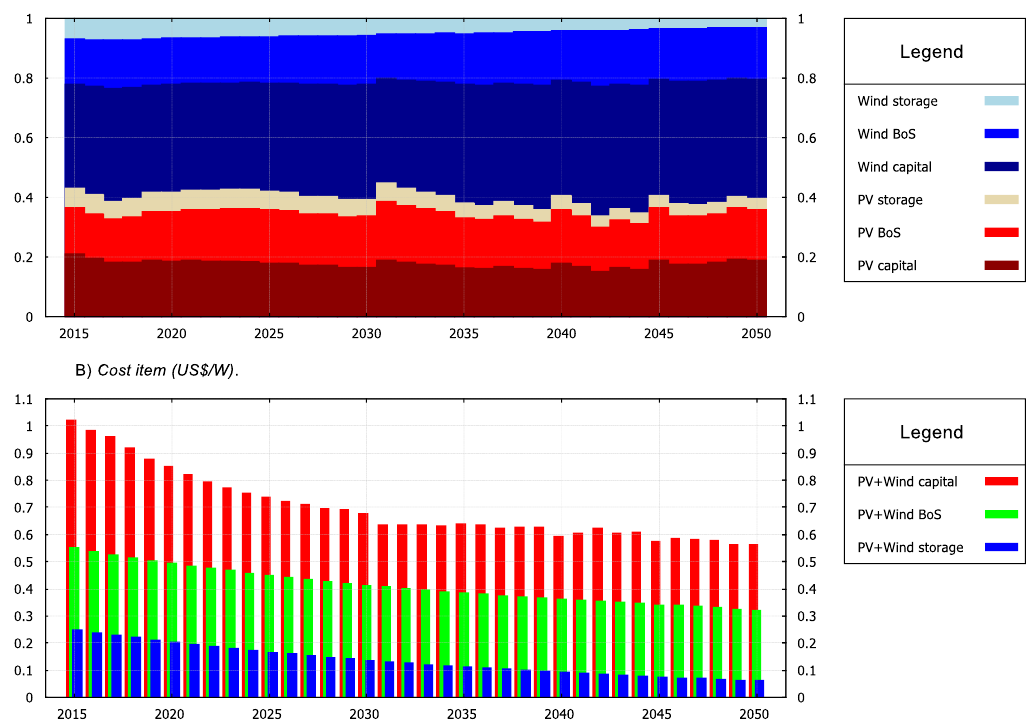
Figure 5. Timeline of capital costs breakdown. Balance of system costs (BoS).